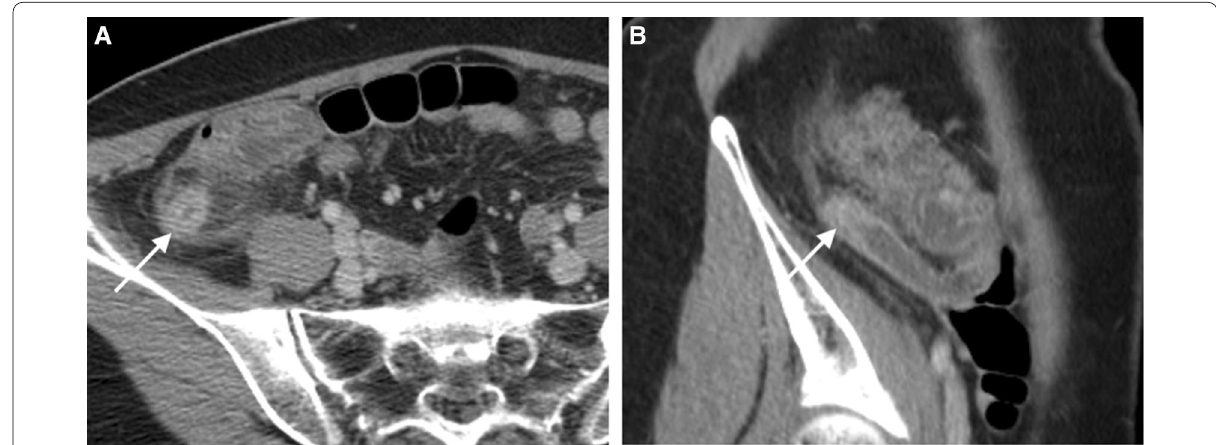
Fig. 5 Mucosal hyperenhancement. Axial ( a ) and sagittal-reformatted ( b ) CT images of a 58-year-old woman presenting with right lower quadrant pain for 16 h, elevated white blood cell counts (10,060 cells/mm 3 ) and neutrophilia (71.3% neutrophils) show an enlarged appendix with wall thickening and hyperenhancement at its distal end (arrow). Note moderate-to-severe periappendiceal fat stranding. Gangrenous appendicitis